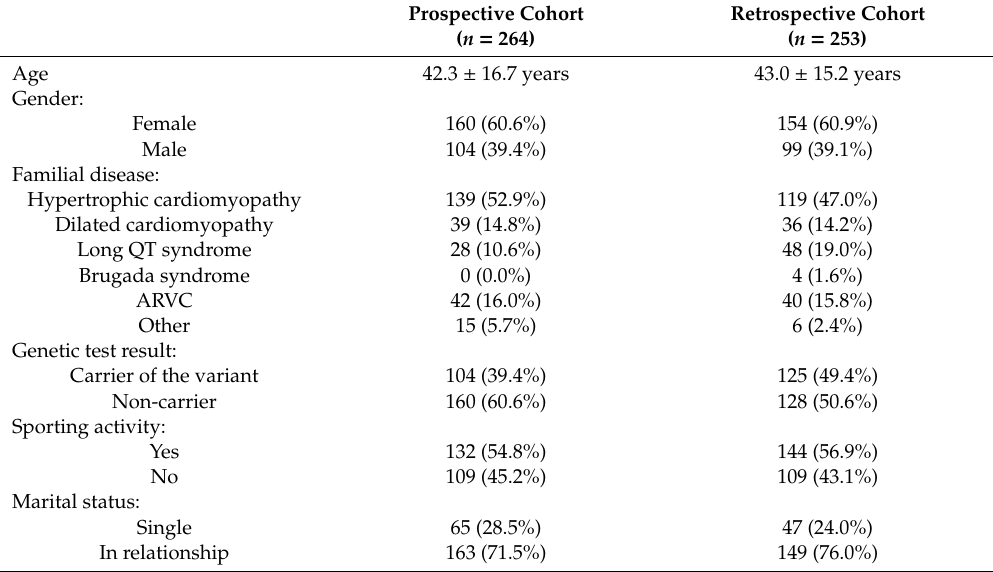
Figure 1. Flow chart of enrolment. * Inclusion or exclusion criteria not respected: risk of vascular disease (Marfan syndrome) ( n = 6), abnormal cardiovascular findings ( n = 1), no sampling after provision of information ( n = 2), unwilling to complete questionnaire ( n = 2), predictive genetic testing not done because mutation reclassified as a polymorphism ( n = 3); ** Inclusion or exclusion criteria not respected: abnormal cardiovascular findings ( n = 3), received test result by post, with no physical meeting ( n = 6), failure to collect test result ( n = 1), already included in the PCo ( n = 1), interval between disclosure of test result and sending of completed questionnaire < 30 days ( n = 7). Table 1. Sociodemographic characteristics of the